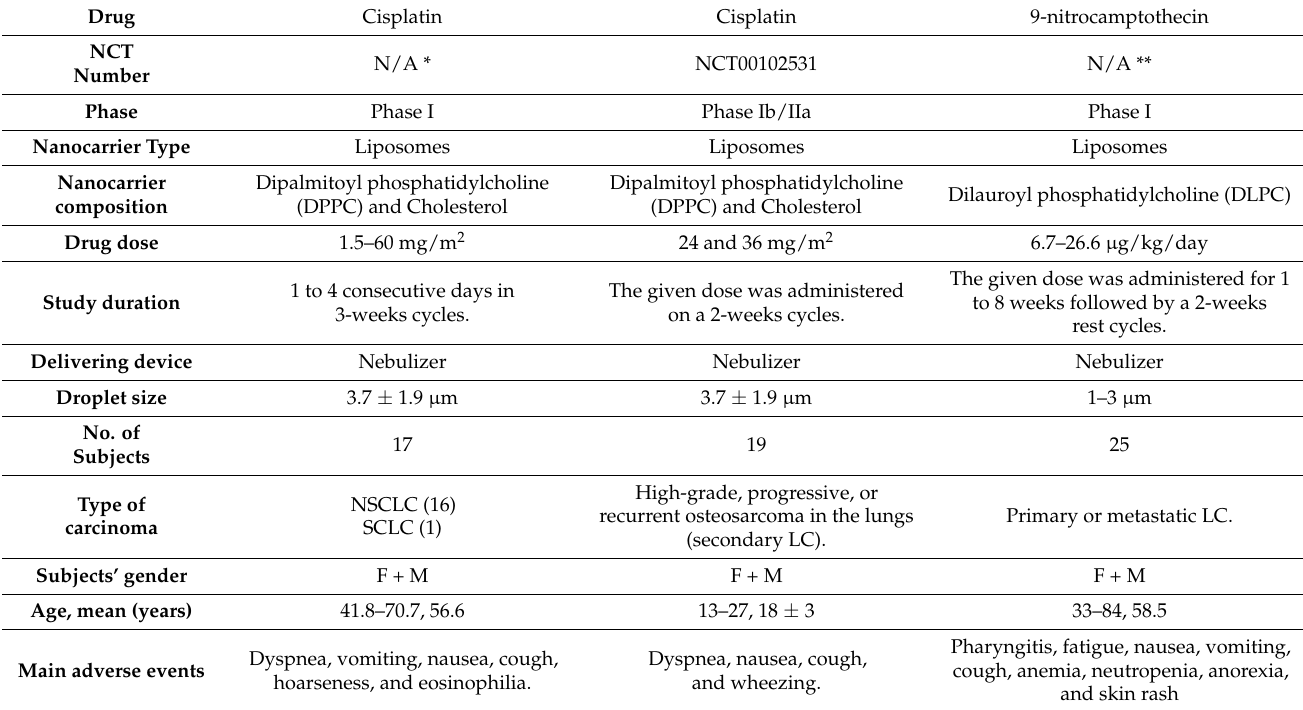
Table 3. Summary of clinical trials that have been conducted on the inhalable anticancer drug-loaded lipid-based nanocarri- ers for the treatment of